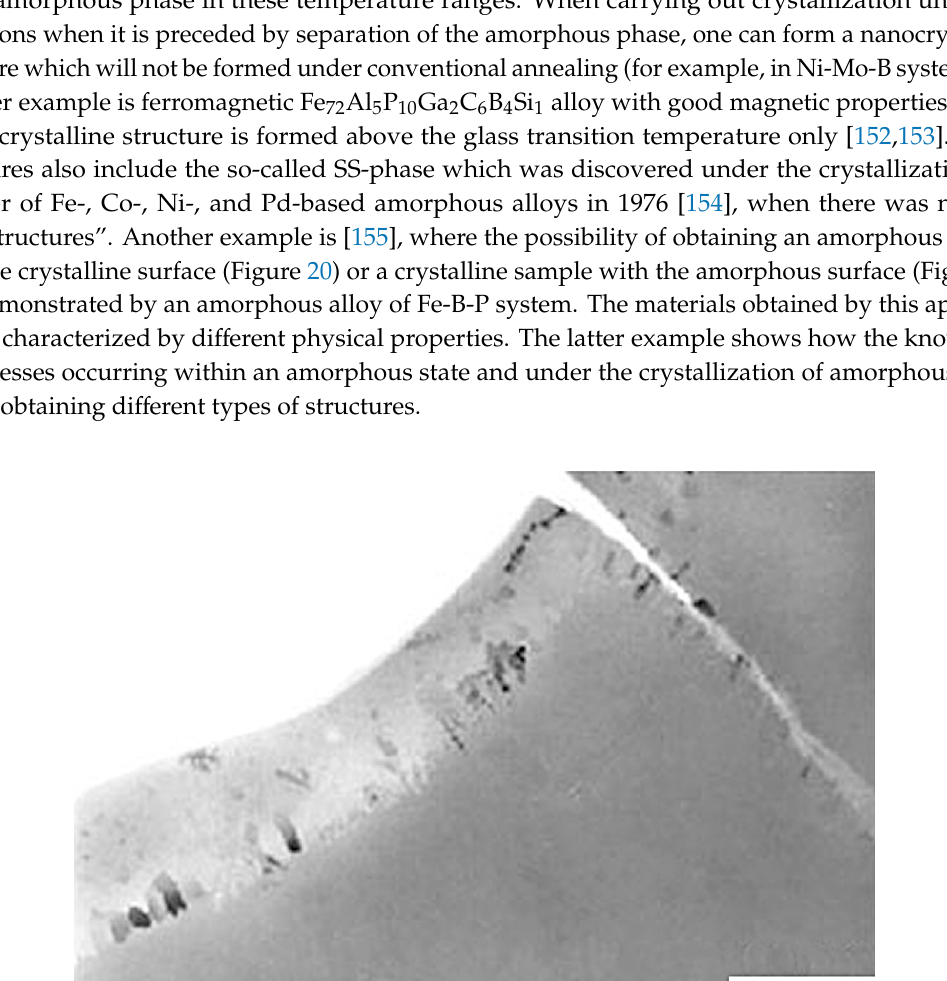
Figure 20. Microstructure of Fe83B10P7 alloy sample partially crystallized in-situ [reproduced from Physics of The Solid State 1991, 33, 2527 with permission from Pleiadis Publishing, 2020 ] [155].